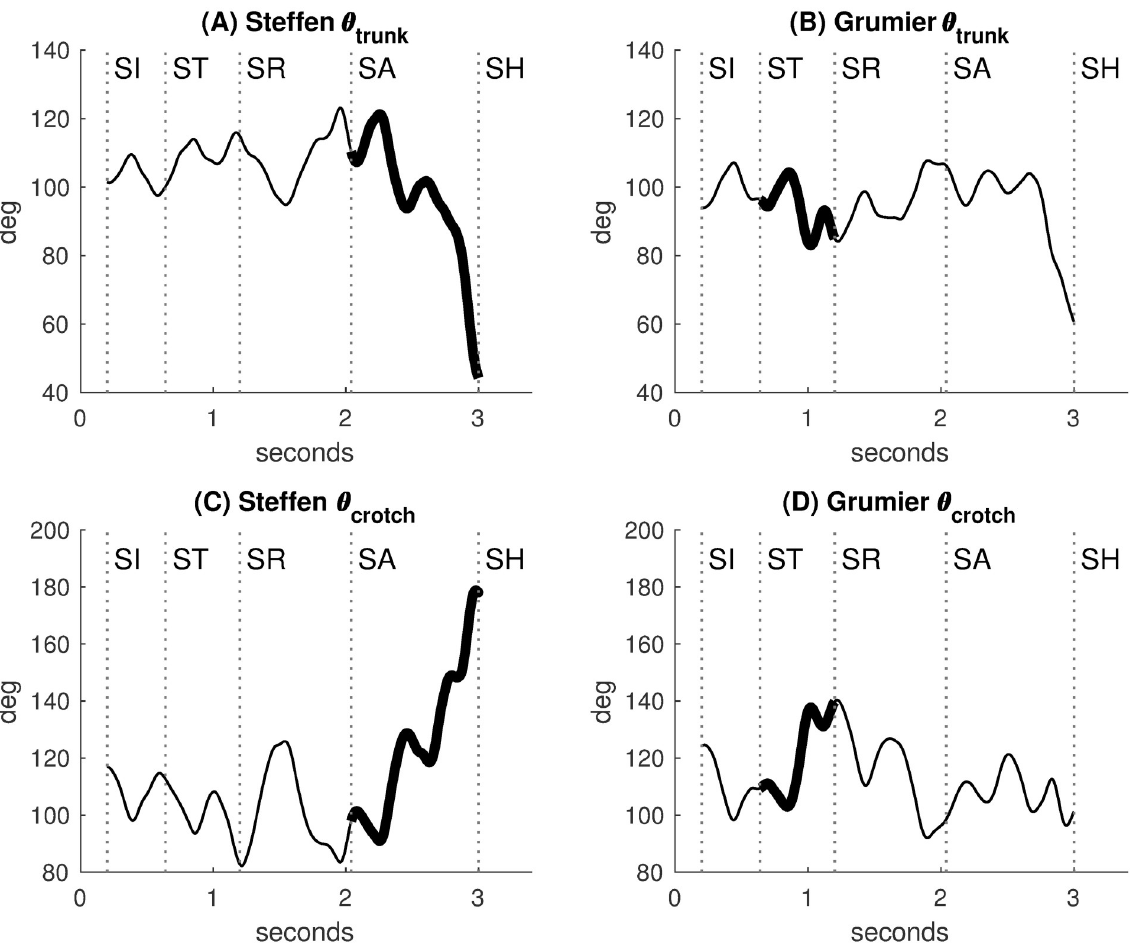
Fig 13. Trunk and crotch angles. (A) The trunk angle dramatically decreases during the Steffen’s attack. (B) The trunk angle decreases during the Grumier’s threat. (C) The crotch angle dramatically increases during the Steffen’s attack. (D) The crotch angle increases during the Grumier’s